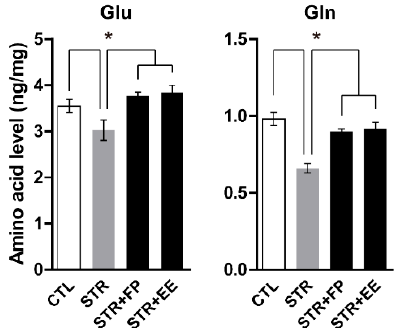
Figure 3 . Glu and Gln changed by CIS and spinach extract-supplemented diet during chronic immobilization stress. Glu and Gln levels in the prefrontal cortex (PFC; n = 5–6 mice per group). All values are means ± standard error of mean (SEM). * p < 0.05. CTL, control; EE, ethanol extract; FP, frozen powder; STR, stress.